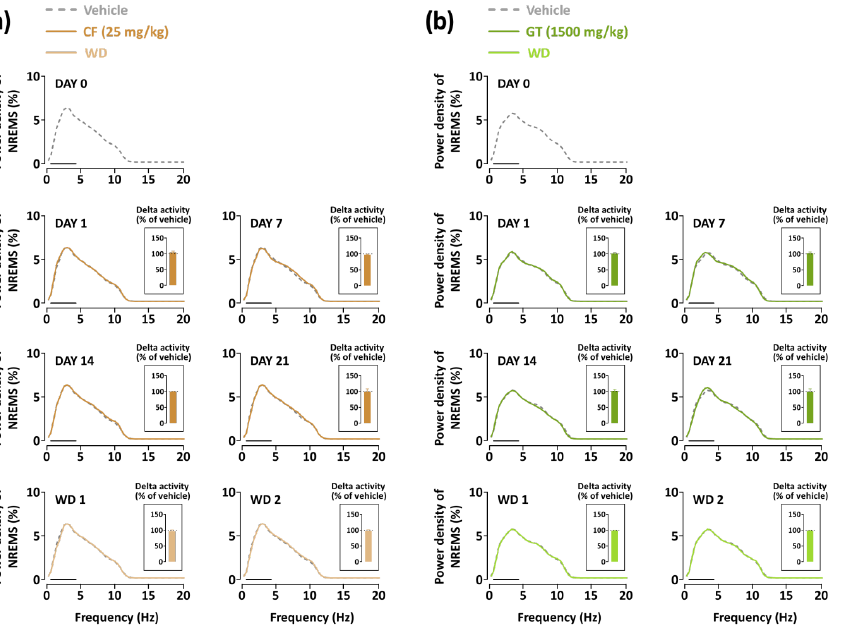
Figure 7. Changes in the EEG power density curve in NREMS during the administration of ( a ) caf- feine and ( b ) GT. Grey curves illustrate the baseline day (vehicle). Brown and green curves illustrate caffeine and GT treatments, respectively. Light brown and green curves illustrate the withdrawal (WD) days. The solid bar ( — ) illustrates the delta wave range from 0.5 to 4 Hz. The delta activity compared with vehicle is presented in the inset bar graph. CF, caffeine; GT, green tea ethanol extract; NREMS, non-rapid-eye-movement sleep; Wake, wakefulness.